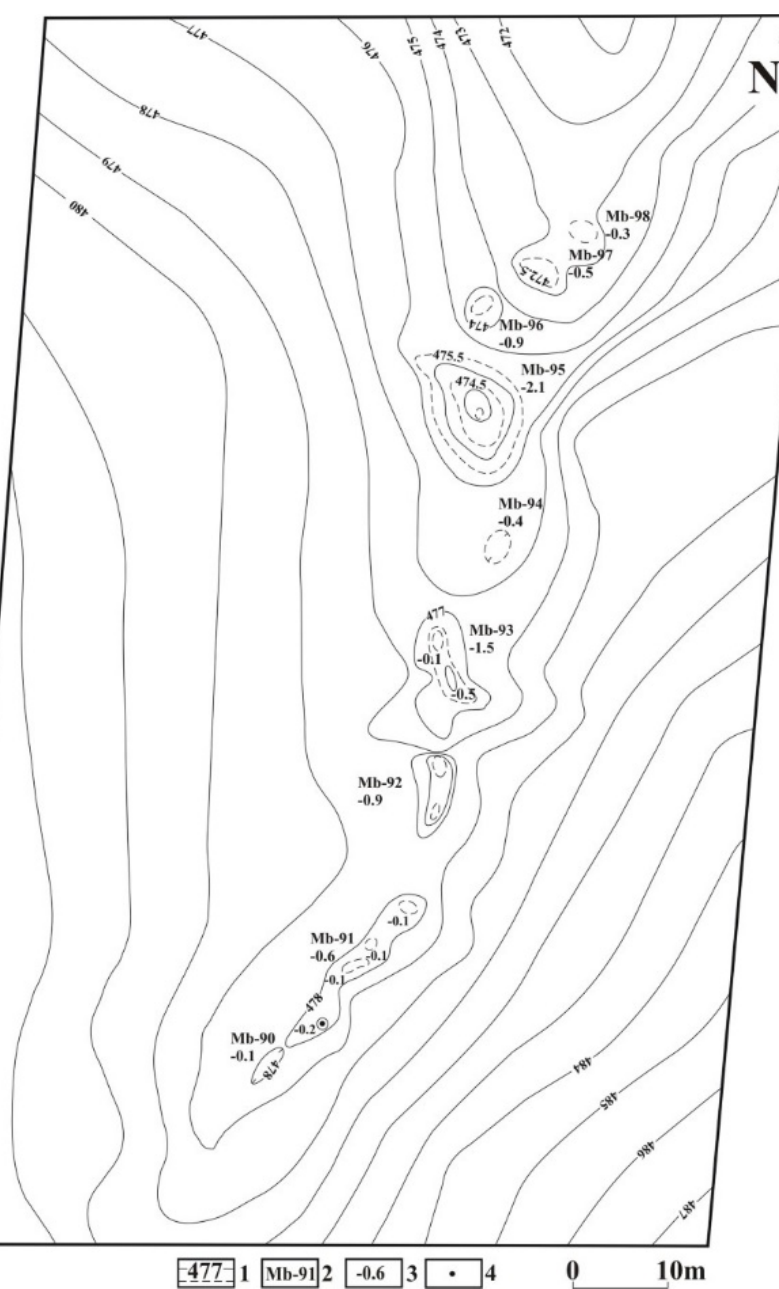
Figure 10. Floor dolines of creek (Bakony Region) [11]. 1. main and auxiliary contour line, 2. doline identification mark, 3. doline depth, 4. passage of doline.